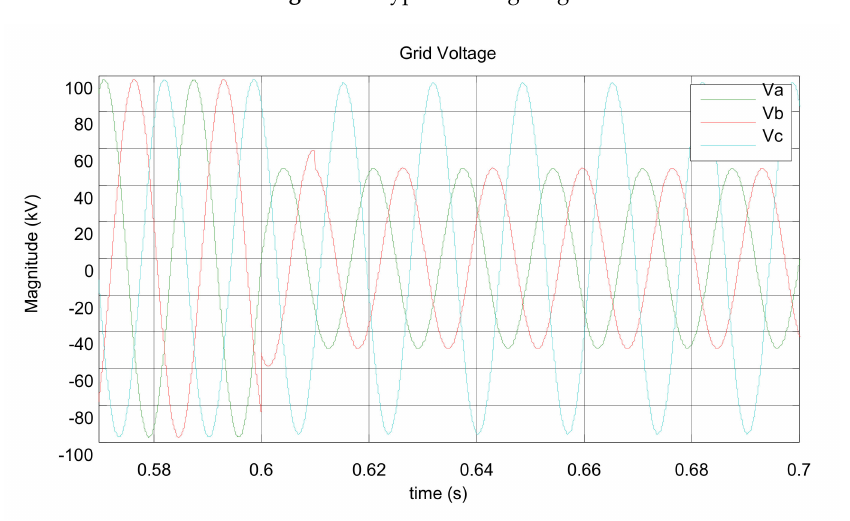
Figure 16. ‘type B’ voltage sag.